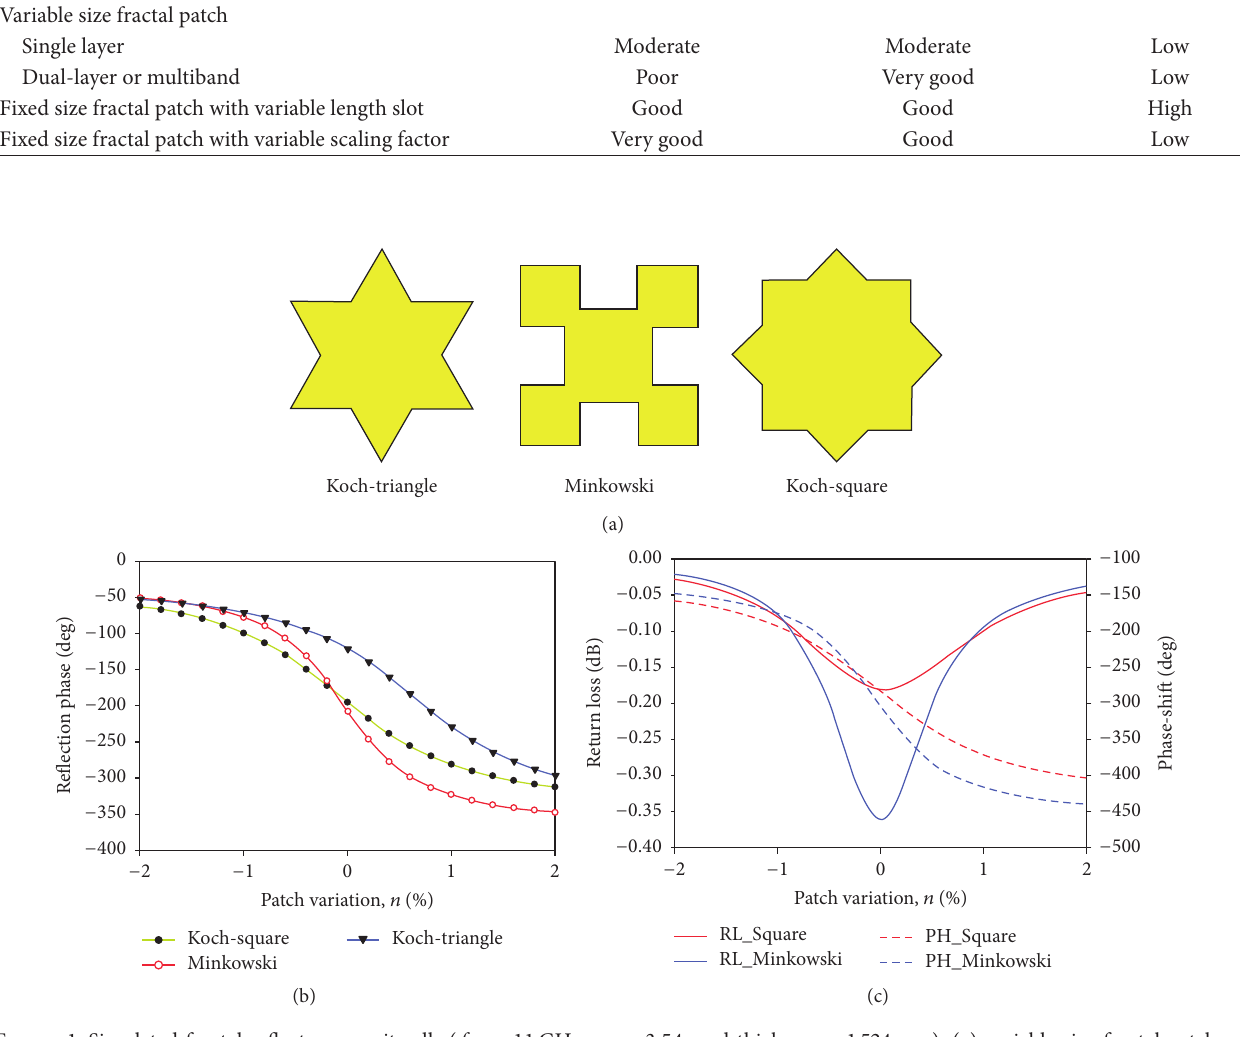
Table 1: Selected approaches for fractal reflectarray unit cell implementation and qualitative analysis of a few related features. Phase tuning approach